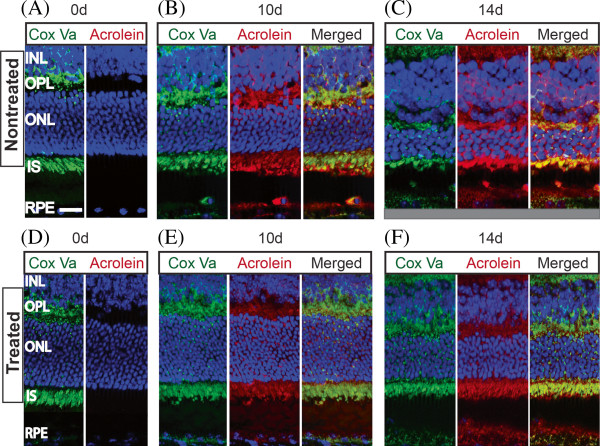
Immunohistochemical analysis of Cox Va and acrolein. (A-F) Effects of 670 nm light treatment on the metabolic status and oxidative stress profiles of the mouse retinas following exposure to 10d and 14d of hyperoxic exposure were examined by immunohistochemical staining. Cryosectioned retinas from the inferior region of the NT and Tr groups were labelled with marker for mitochondrial metabolism, Cox Va (green) and indicator of oxidative stress, acrolein (red). Compared to 0d control retina (A), Cox Va labelling patterns (green) in the 10dNT and 14dNT were disrupted (B-C, green) but not in the 10dTr and 14dTr groups (E-F, green). Exposure to hyperoxia caused a significant increase in the acrolein expression in 10dNT and 14dNT retinas (B-C, red) compared to 0d control (D). The acrolein labelling was also present in the 10dTr and 14dTr groups but the intensity was much lower than the NT retinas (E-F, red). Scale bar 25 μm.